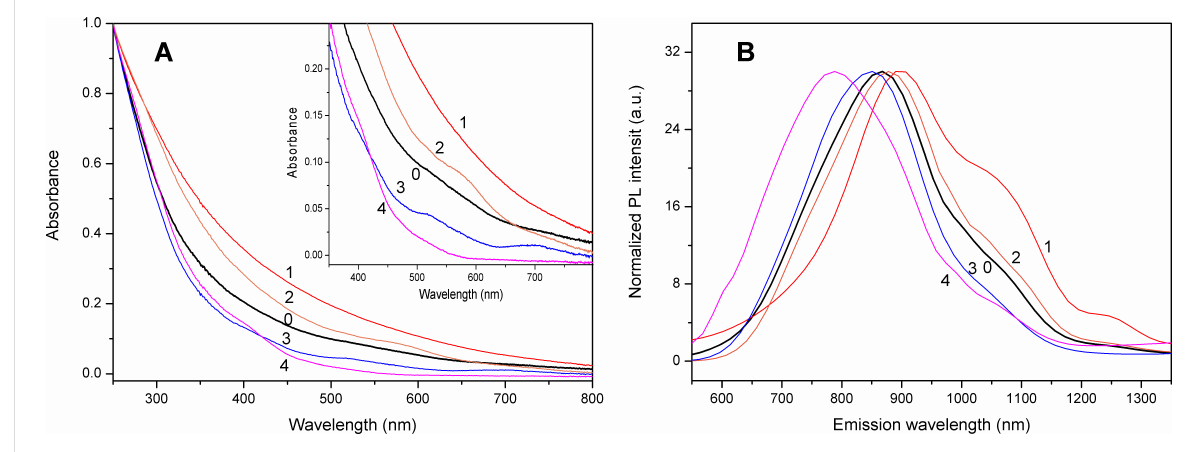
Figure 9: (A) UV–visible absorption and (B) corrected photoluminescence spectra (excited at 380 nm) of the (0) crude penicillamine-protected AuNC product and the sequential size-selected fractions (1) F 36% , (2) F 54% , (3) F 72% , and (4) F 90% . The UV–visible spectra are normalized at 250 nm to remove the effect on concentration difference. The inset depicts the enlarged UV–visible spectra in the range 350 − 800 nm for clarity and ease of